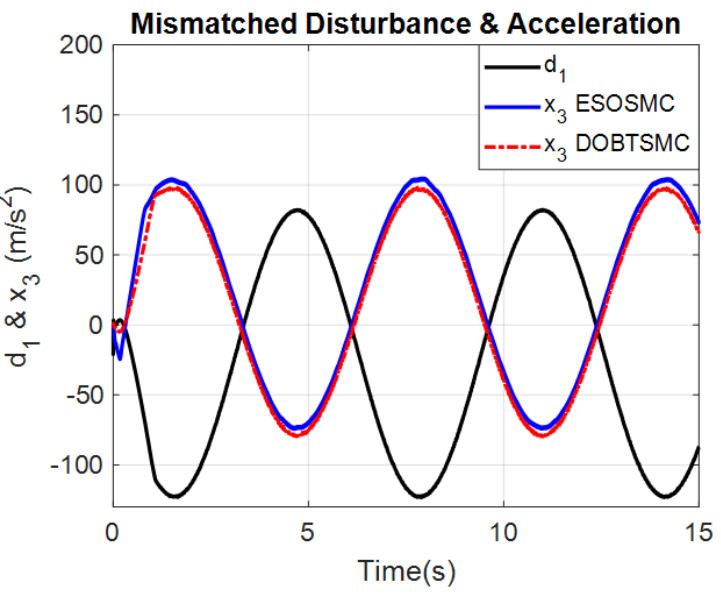
Figure 10. Mismatched disturbance and acceleration signal of the EHA system.